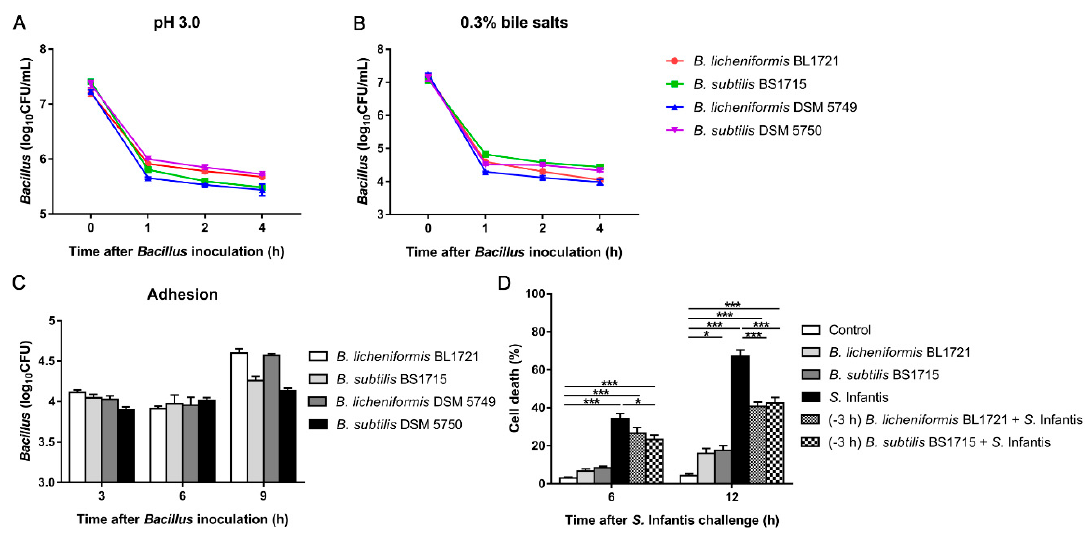
Figure 1. In vitro assessment of Bacillus for use as livestock probiotics. Survival of Bacillus in pH 3.0 ( A ) and 0.3% porcine bile salts ( B ). ( C ) The ability of Bacillus to adhere to epithelial cells. ( D ) Trypan blue staining was used to investigate cell death, the results are presented as the ratio of the number of dead cells to the total number of cells. All analyses were performed in triplicate. * p < 0.05; ** p < 0.01; *** p < 0.001.